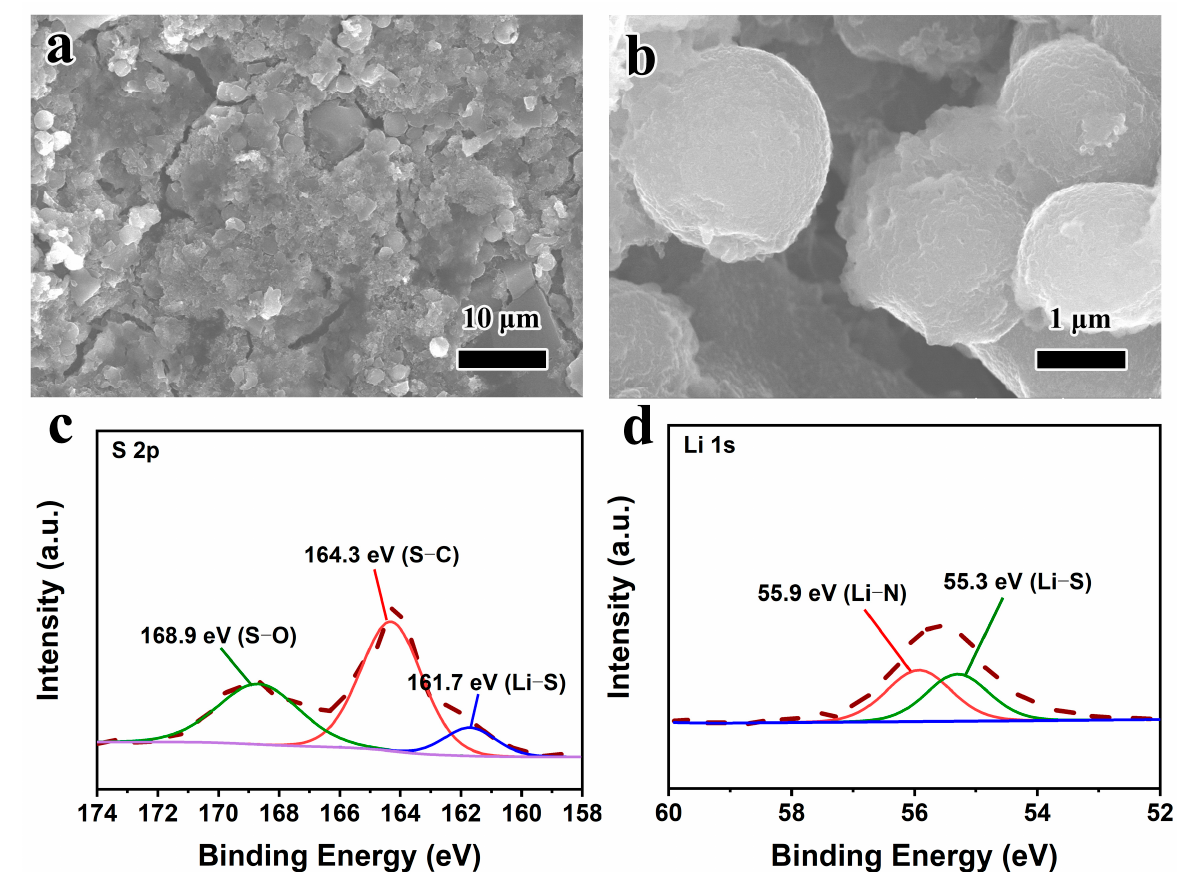
Figure 6. SEM images of NPCMs–Li 2 S electrode after 500 cycles at 1.0 A g − 1 ( a ) attached on current collector and ( b ) detached from current collector. XPS spectra of NPCMs–Li 2 S electrode after 500 cycles at 1.0 A g − 1 ; ( c ) S 2p spectrum and ( d ) Li 1s spectrum.